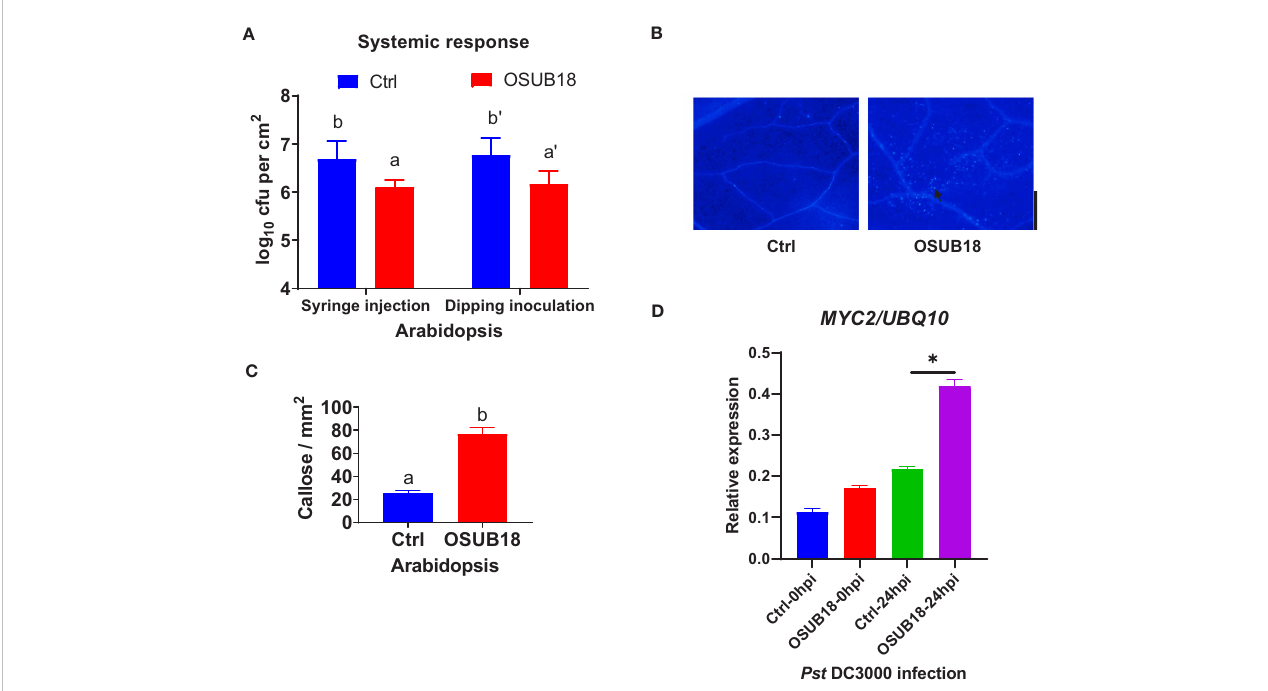
FIGURE 4 OSUB18 root-drench treatment triggered strong ISR in A thaliana against the bacterial pathogen Pst DC3000 attack via signi fi cantly more callose deposition and a signi fi cantly higher level of the MYC2 gene expression. (A) OSUB18 root-drench treatment increased the host plant defense of Col-0 plants against Pst DC3000 infection. (B) Col-0 plants drenched with OSUB18 deposited signi fi cantly more callose upon the Pst DC3000 infection (24hpi), as illustrated by the aniline blue staining assay. The black arrow indicates a representative callose. Scale bar = 500 µm. (C) Quanti fi cation of the callose deposition in (B) . (D) The relative expression level of the ISR-responsive gene MYC2 . Water or OSUB18-drenched Col-0 plants were infected with Pst DC3000 by syringe injection. 0 or 24 hours later, the injected leaves were collected for the qRT-PCR assay. The UBQ10 gene was used as an internal reference in the qRT-PCR assay. Data present mean ± SE of three biological replicates. Data with different letters or * indicate a p- value < 0.05 on Student ’ s